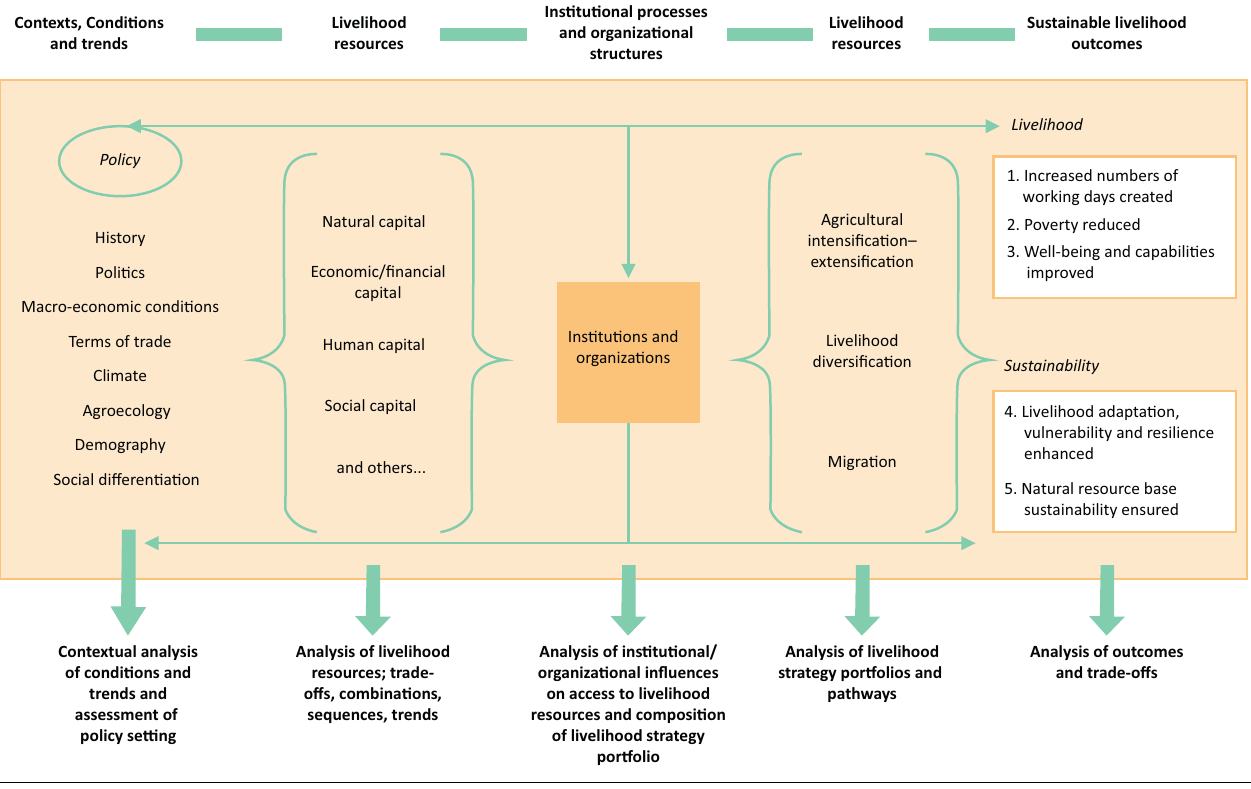
FIGURE 1: Sustainable livelihoods framework.